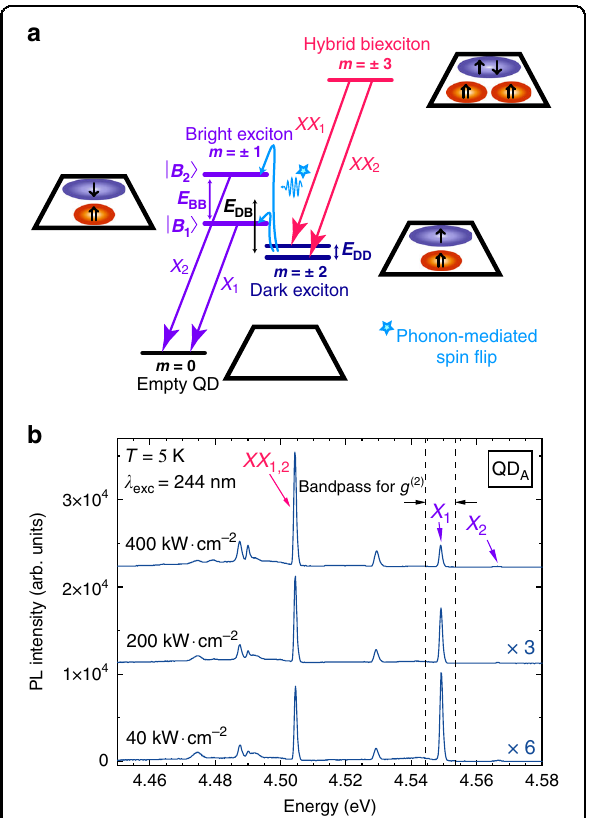
Fig. 2 Exciton-biexciton photoluminescence from SA GaN/AlN QDs. a Schematic illustration of the hybrid exciton-biexciton cascade. b Power-dependent µ-PL spectra of QD A exhibiting X 1,2 and XX 1,2 transitions recorded at 5